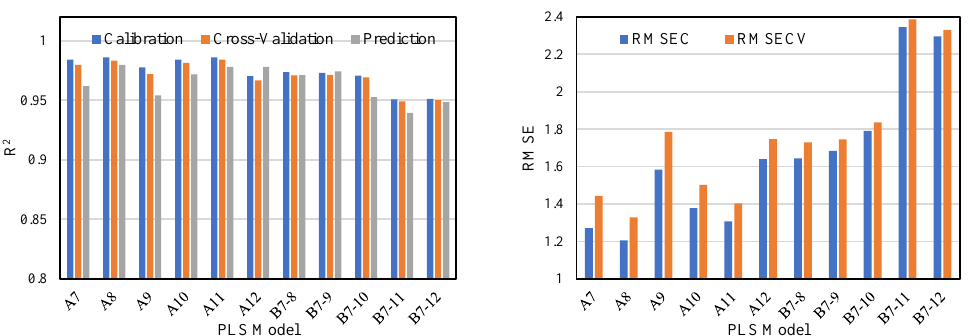
Figure 6. Prediction accuracy of capsaicinoid(A), free sugar(B) and ASTA color(C) of red pepper